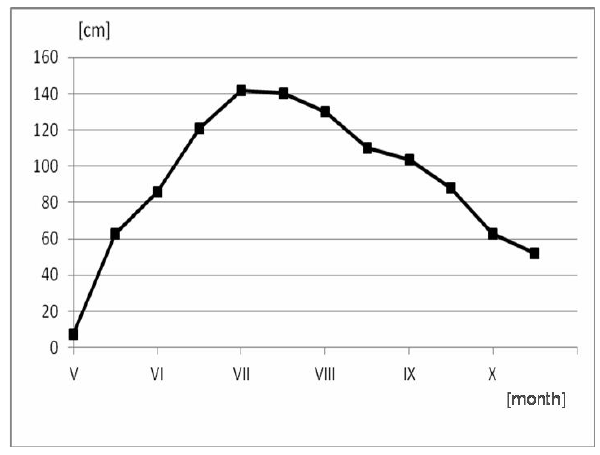
Figure 4: Prairie cordgrass growth dynamics – Table 7: Number of shoots per 1 m 2 and biomass yield (means by factors and years).